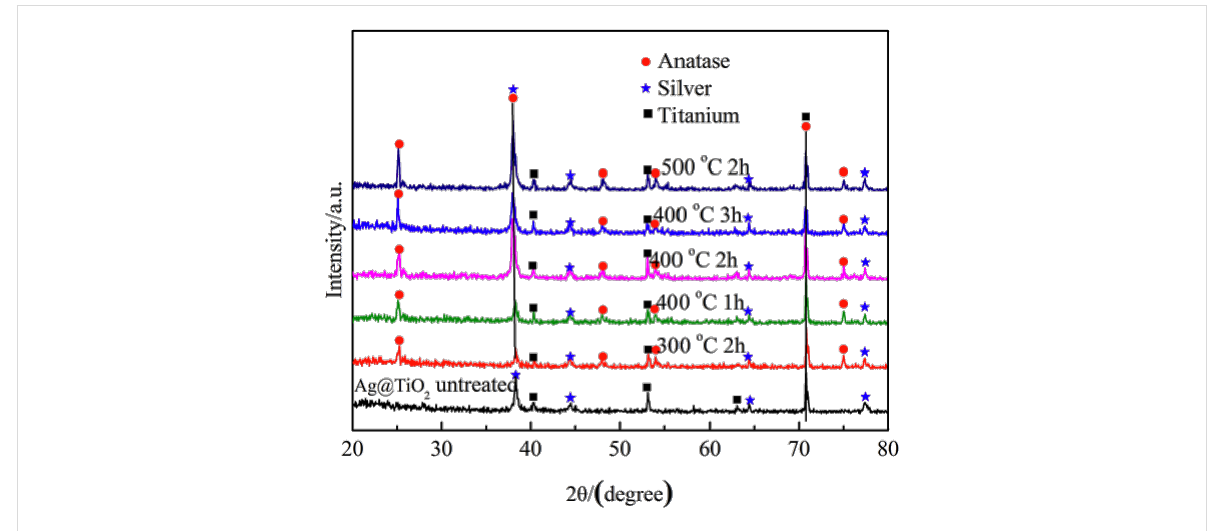
Figure 4: XRD patterns of TiO 2 nanotube arrays with Ag nanofilm heat treated at three different temperatures for different periods of time.